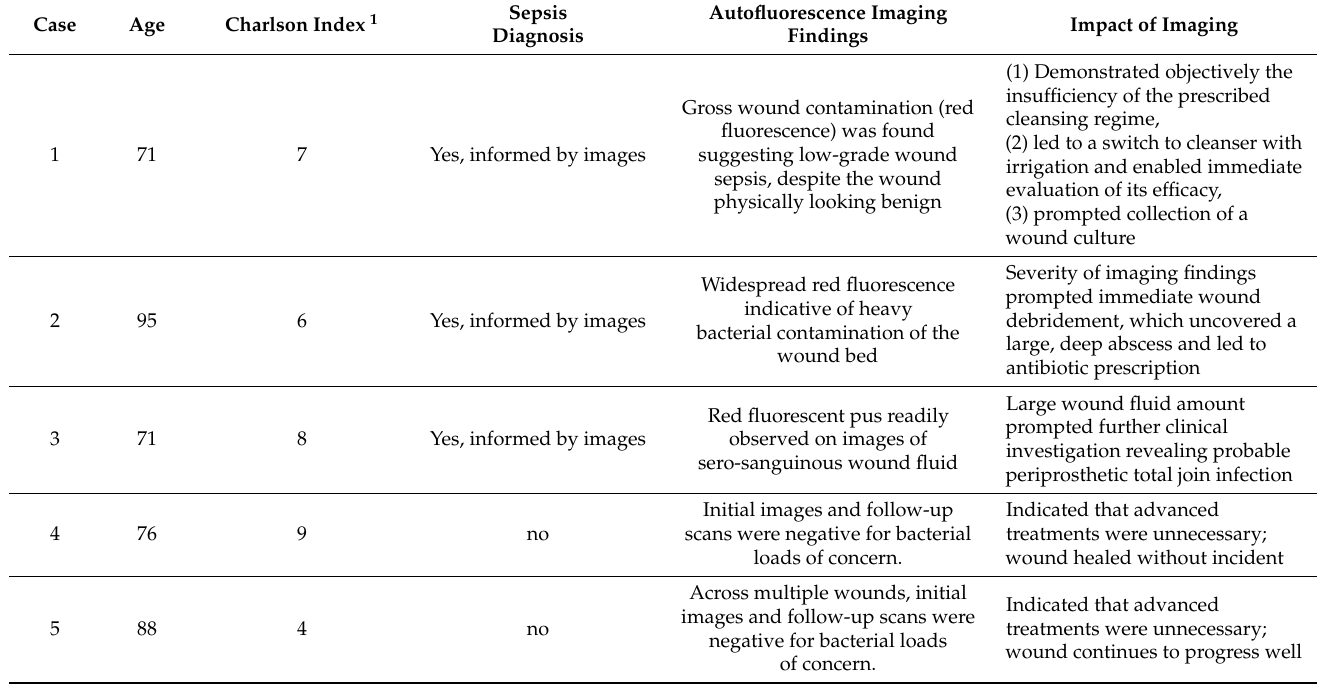
Table 1. Summary of cases and imaging